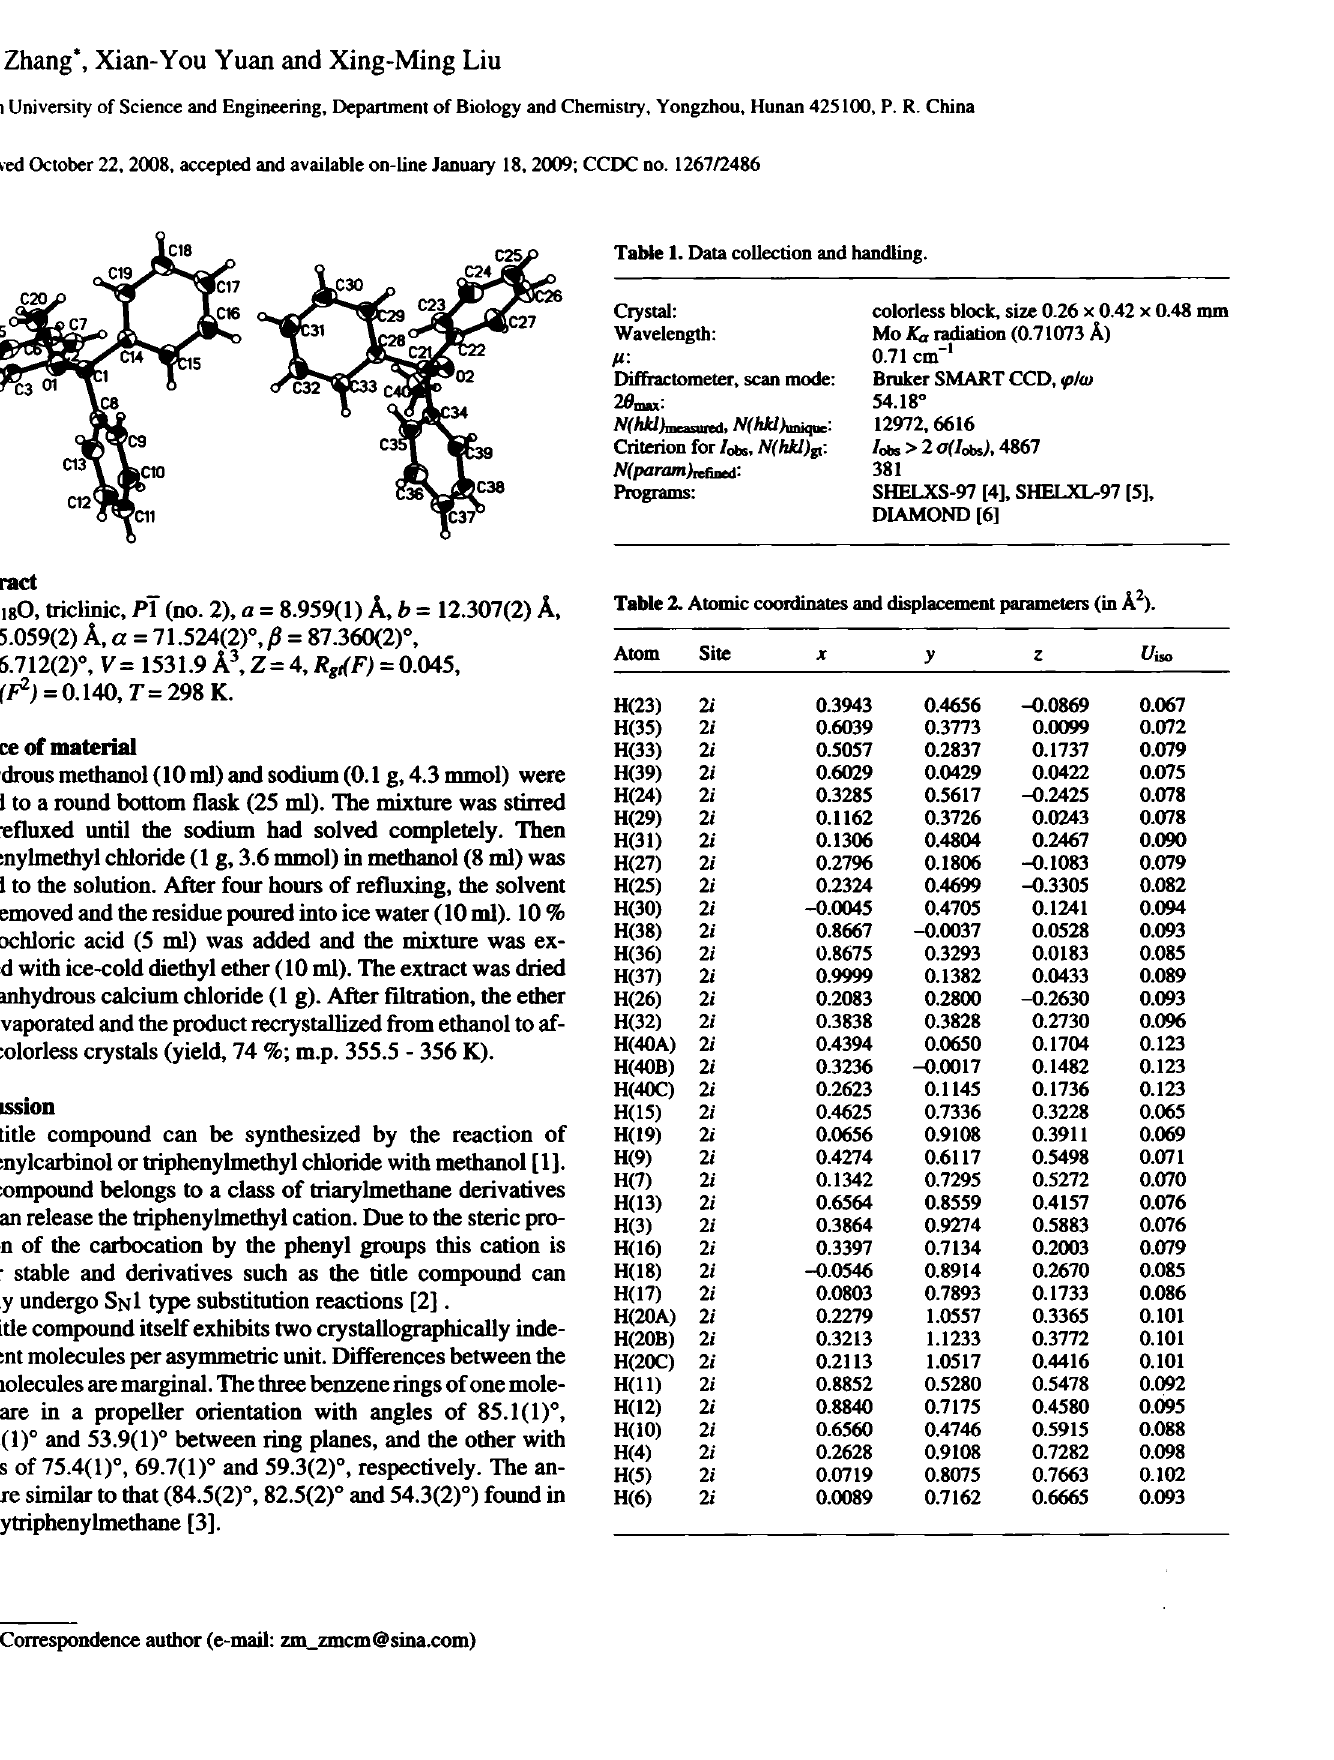
Table 1. Data collection and handling.